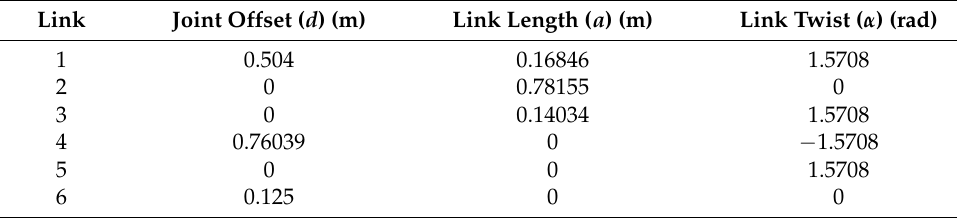
Table 7. ERC20-C10 modified DH